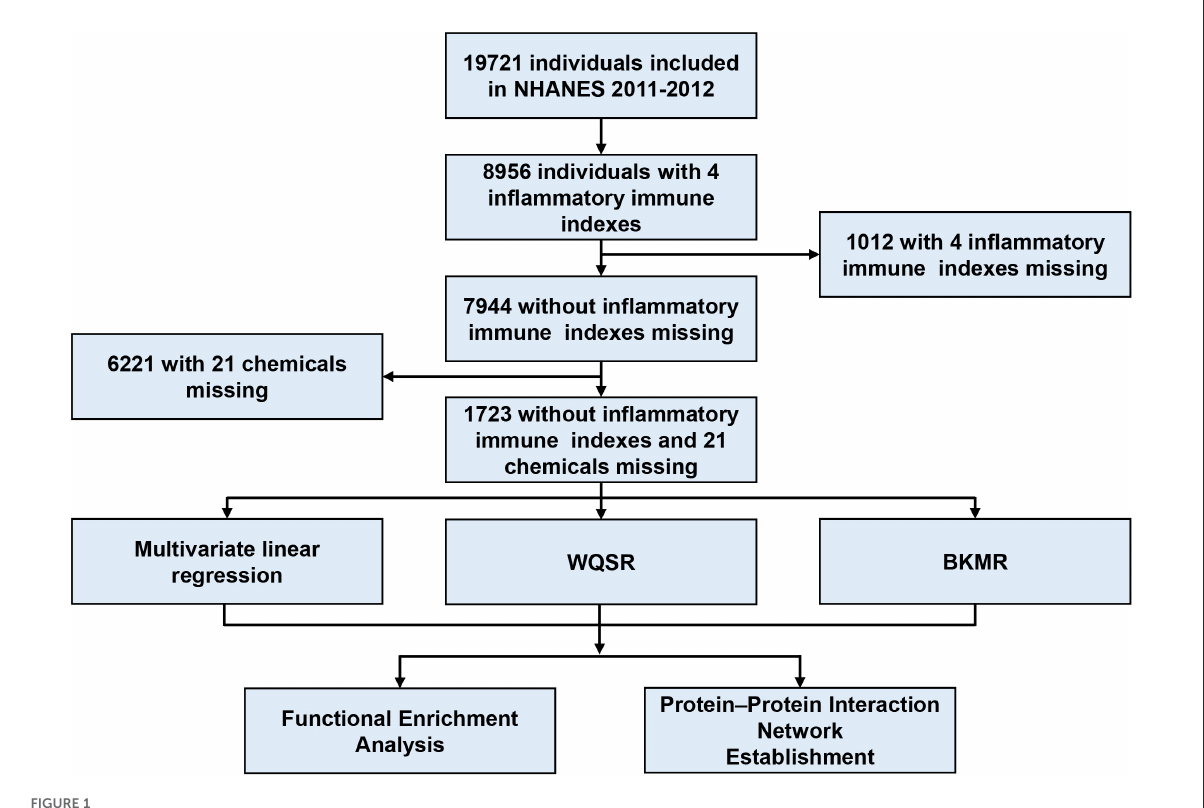
FIGURE1 Flowchart for inclusion of study